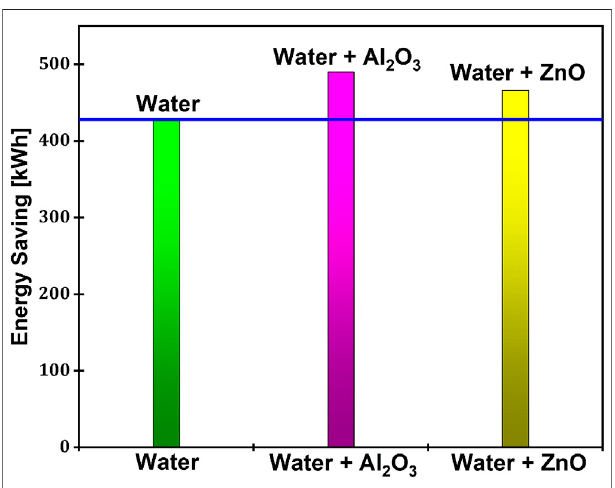
FIGURE 14 | Energy saving in the solar